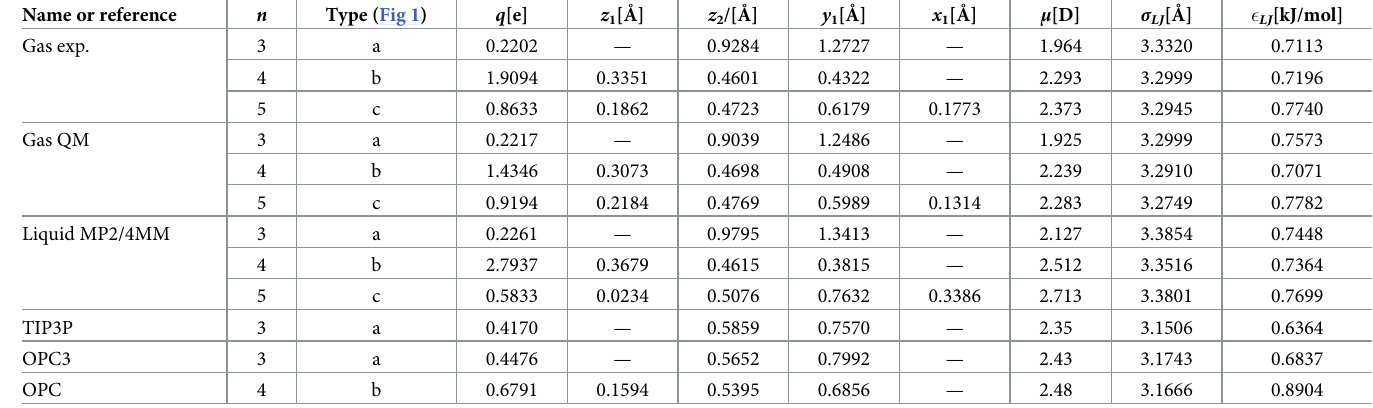
Table 2. Parameters of 3, 4 and 5-point optimal water models, and their geometry (Fig 1). For comparison, parameters of several existing models are shown in the bot- tom rows. Name or